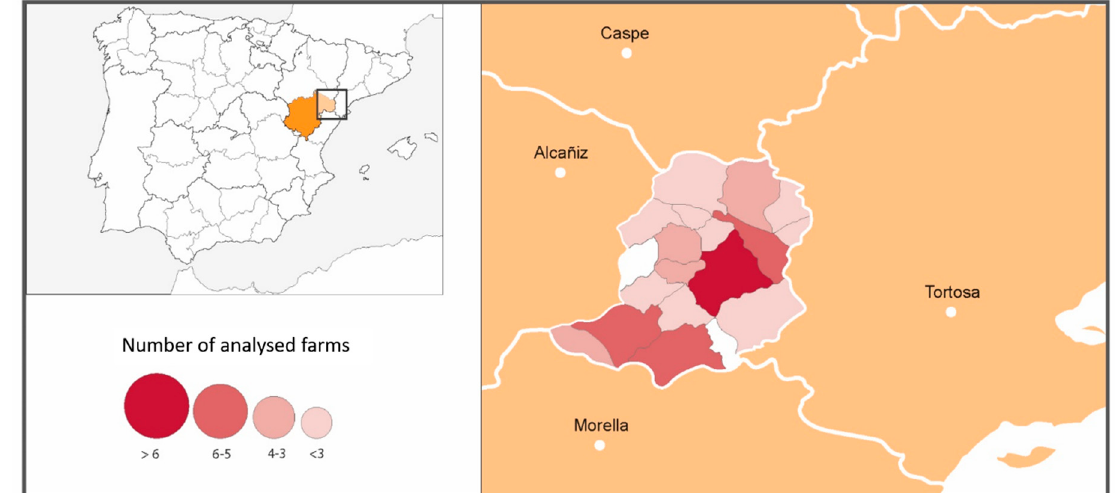
Figure 1. Number of farms sampled by municipalities within the Matarraña region. In the Matarraña region, despite its small size (926.06 km 2 ), there are two well-differ- entiated natural areas. The northern region, Bajo Matarraña, is characterised by a conti- nental climate with open spaces with small elevations. The main crops are olive trees (Olea Europea), almond trees (Prunus dulcis) and rainfed cereal, interspersed with forests of Aleppo pine (Pinus halepensis). Meanwhile, the southern region, Alto Matarraña, has a